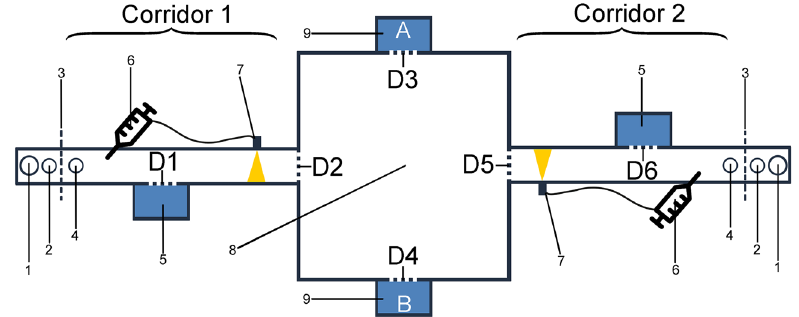
Figure 3. Experimental setup covered with acrylic glass. (1) non-transparent cup for “outer banana”; (2) transparent cup with filter paper for sample placement; (3) grid wall; (4) reward tray for “inner banana”; (5) nest box to enter at the end of each trial (transfer box); (6) apple juice reward injector connected to (7) light barrier; (8) central arena; (9) nest box on starting position (A/B = starting position); D1-6 = electronic doors accessible via remote control; size (LxWxH) of central arena = 70 cm × 70 cm × 40.5 cm; size of corridors = 70 cm × 8 cm × 9.5